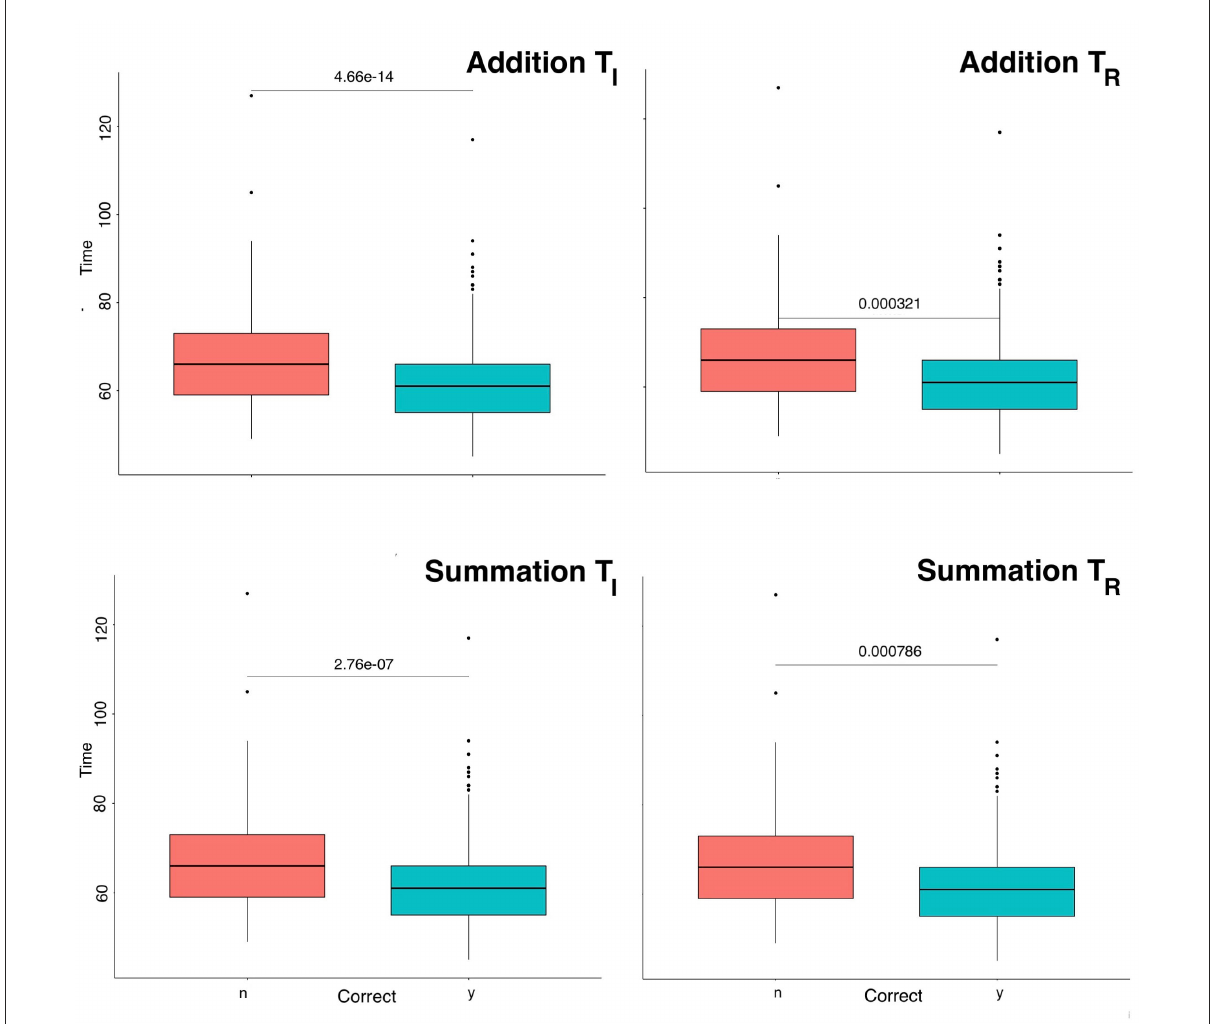
FIGURE2 Boxplot of mental arithmetic response time subsetted by outcome. Response times for errors were consistently longer than correct responses for both tasks. Differences were statistically significant for all study periods ( p < 0.001). T I = initial study period, T R = return study period, Time= task response time, y=yes,